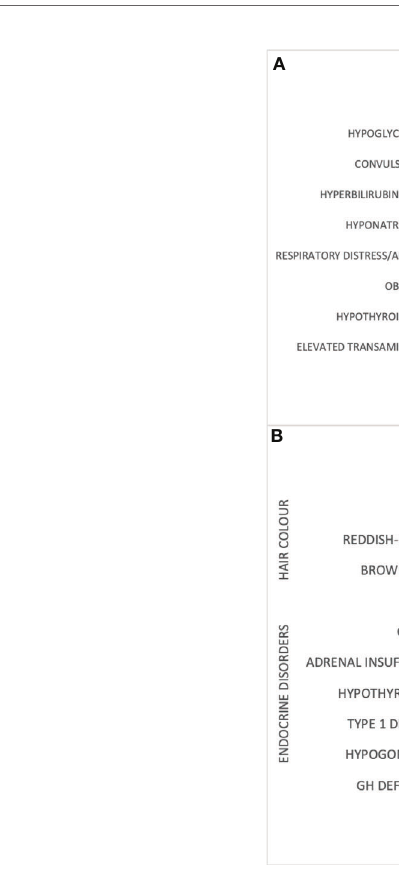
FIGURE 4 | Graphic representation of (A) the frequency of fi rst presenting signs or symptoms and (B) the frequency of clinical